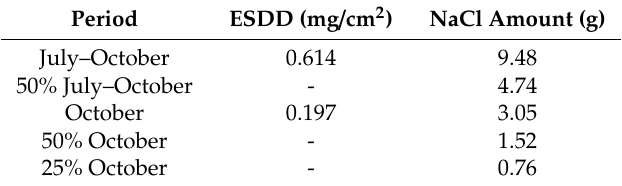
Table 4. Equivalent salt deposit density for each period and the respective amounts of